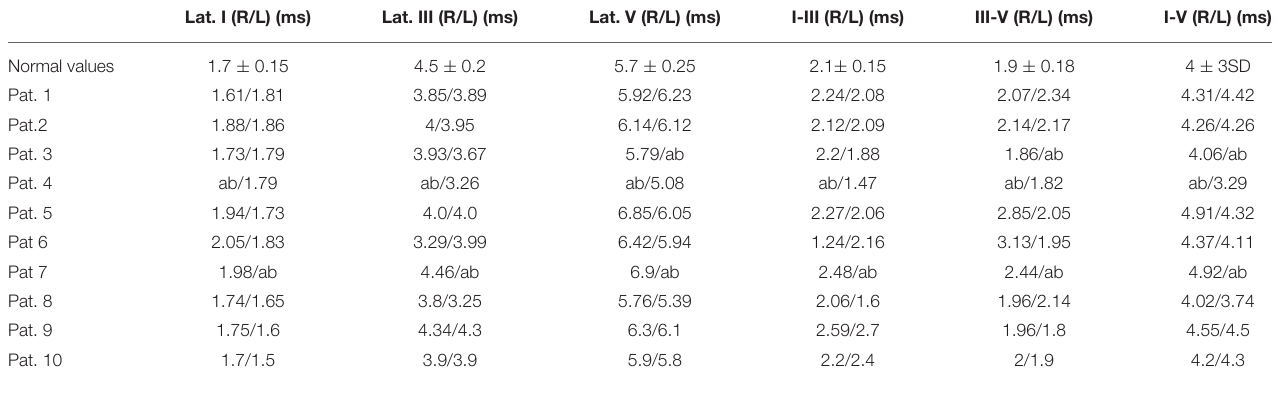
TABLE 1 | Brainstem evoked potential results obtained in the 10 patients evaluated (normal values referred to normative values of our